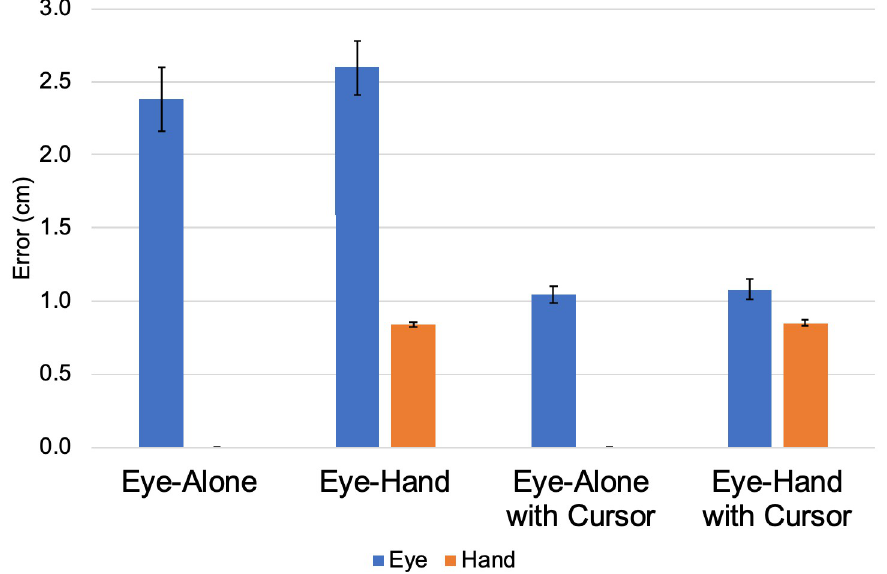
Fig 6. Eye fixation and hand endpoint error. Group-mean eye fixation error and hand endpoint error for each condition including standard error of the mean.